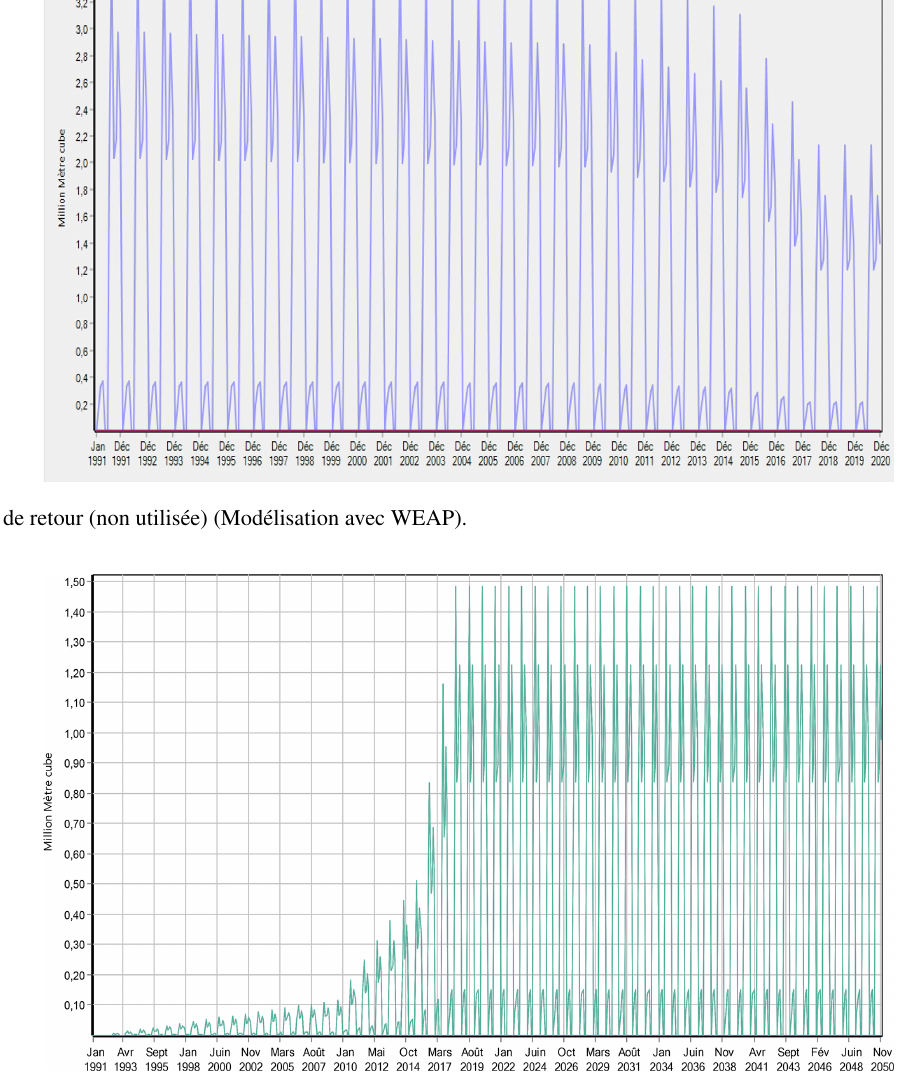
Figure 12. Modélisation de l’utilisation mensuelle de l’eau jusqu’en 2050 (Modélisation avec